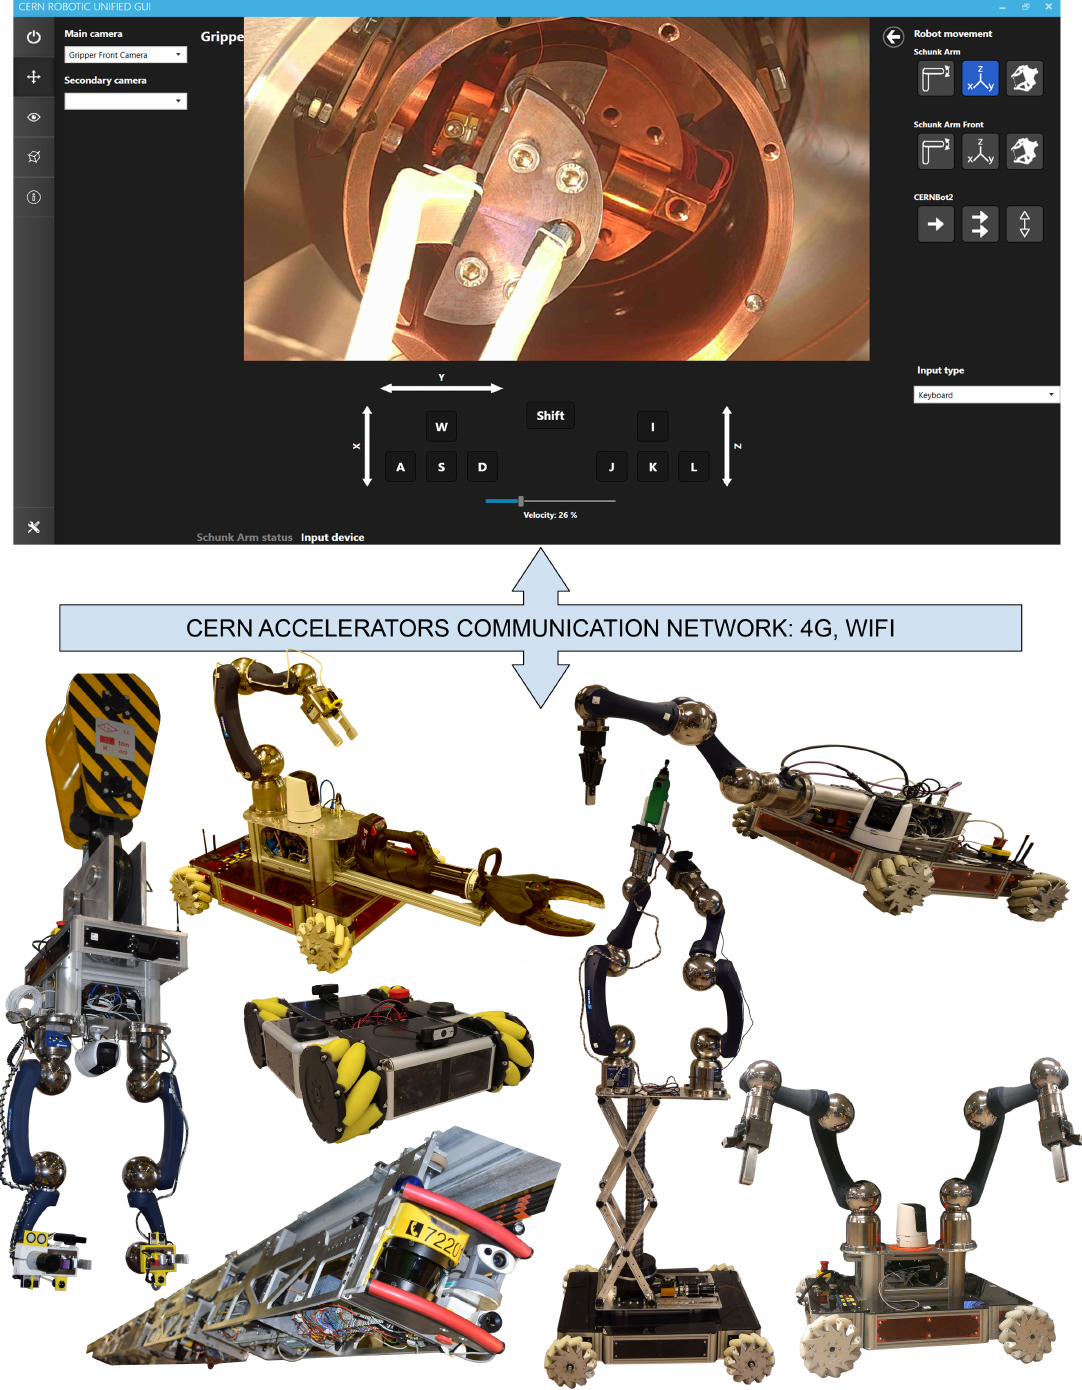
Figure 3. Set of modular robots developed at CERN-EN-SMM-MRO section to perform safe operations in radioactive and hazardous scientific facilities (i.e., Cranebot, Charmbot, CERNBot, CERNBot2, TIM, and Unified